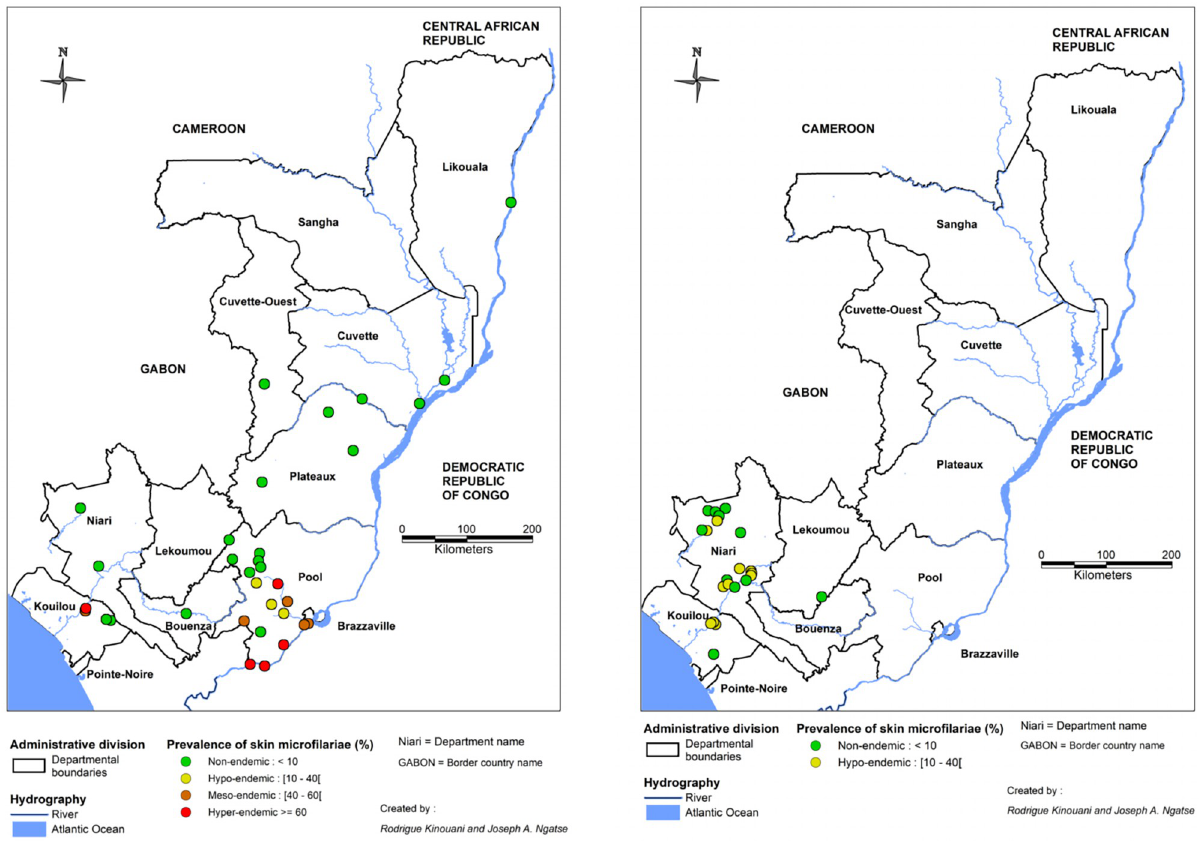
Fig 6. Prevalence of skin O . volvulus microfilariae recorded during surveys in the Republic of the Congo. The left panel shows the results recorded between 1960 (first survey) and 2000 and the right those of the surveys conducted after 2000. The map was created with MapInfo 8.5 (Geographic Information System, http://www.precisely.com). The base layer used of the map was created by the « Laboratoire Population Environnement De´veloppement » (LPD, UMR 151 AMU-IRD) (https://www.lped.fr/-observatoires-societe-environnement-.html) under the supervision of the Ministry of Health and Welfare of the Republic of